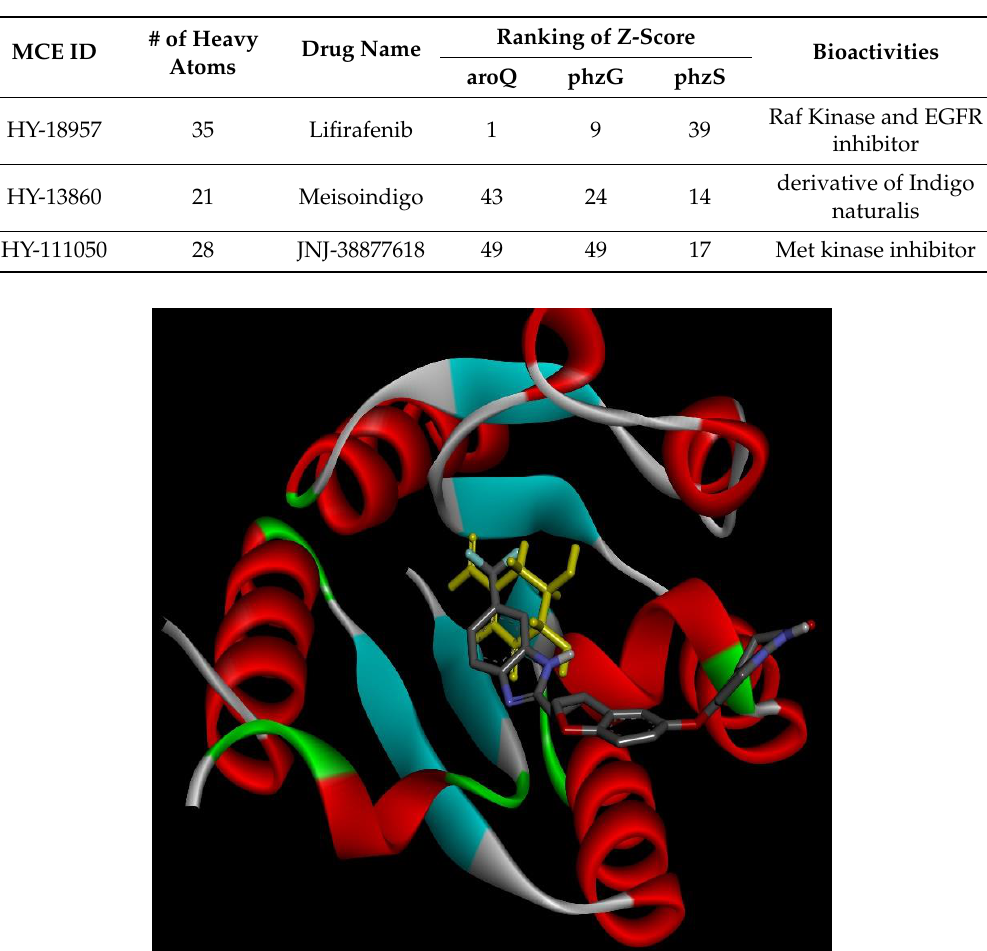
Figure 2. Docking conformation of Lifirafenib (gray stick) and 3DS (yellow stick) in aroQ.